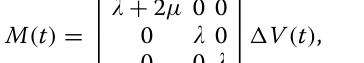
where L , W , and (cid:31) d are the length, width, and aper- ture change of the crack, respectively. The source time (3) M (cid:31) � V ( t ) functions shown in Fig. 9 are defined as S (t) . = We divided the maximum amplitude of the source (cid:31) µ ρ V 2 / 3 time function ( N max max{ S ( t )}) by p = = = (6.44 10 9 Pa) to investigate the maximum value of the × volume change ( (cid:31) V ). To estimate L , W , and (cid:31) d , we need to assume the ratios W / L and L /� d . Taguchi et al. (2018) investigated these ratios for shallow long-period